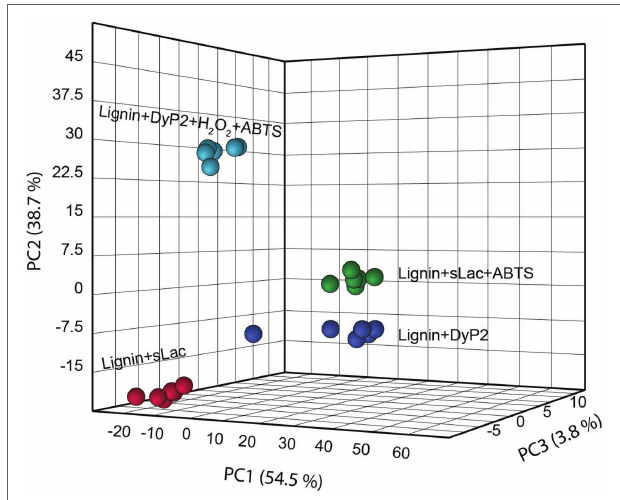
FIGURE 6 | DyP2 and sLac created different PCA clusters in organosolv lignin in the absence or presence of ABTS. Six ToF-SIMS data ( n = 6) of each treatment were acquired as shown as colored